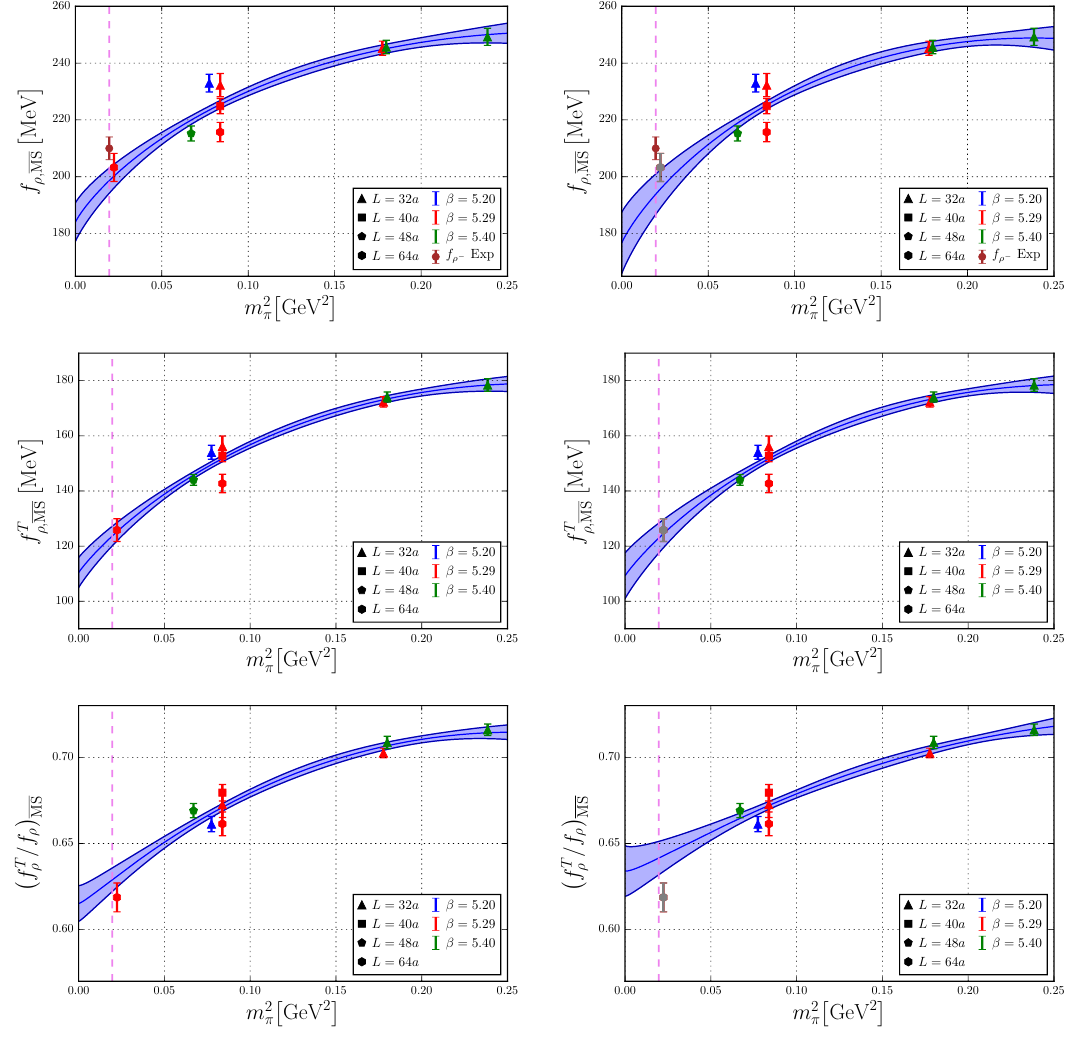
Figure 2 . ChPT (cid:12)ts using eqs. (6.1) for the decay constants f (left) and excluding (right) the data point at m (cid:25) = 150 MeV. The violet dashed line indicates the position of the physical pion mass. The band indicates the one sigma statistical